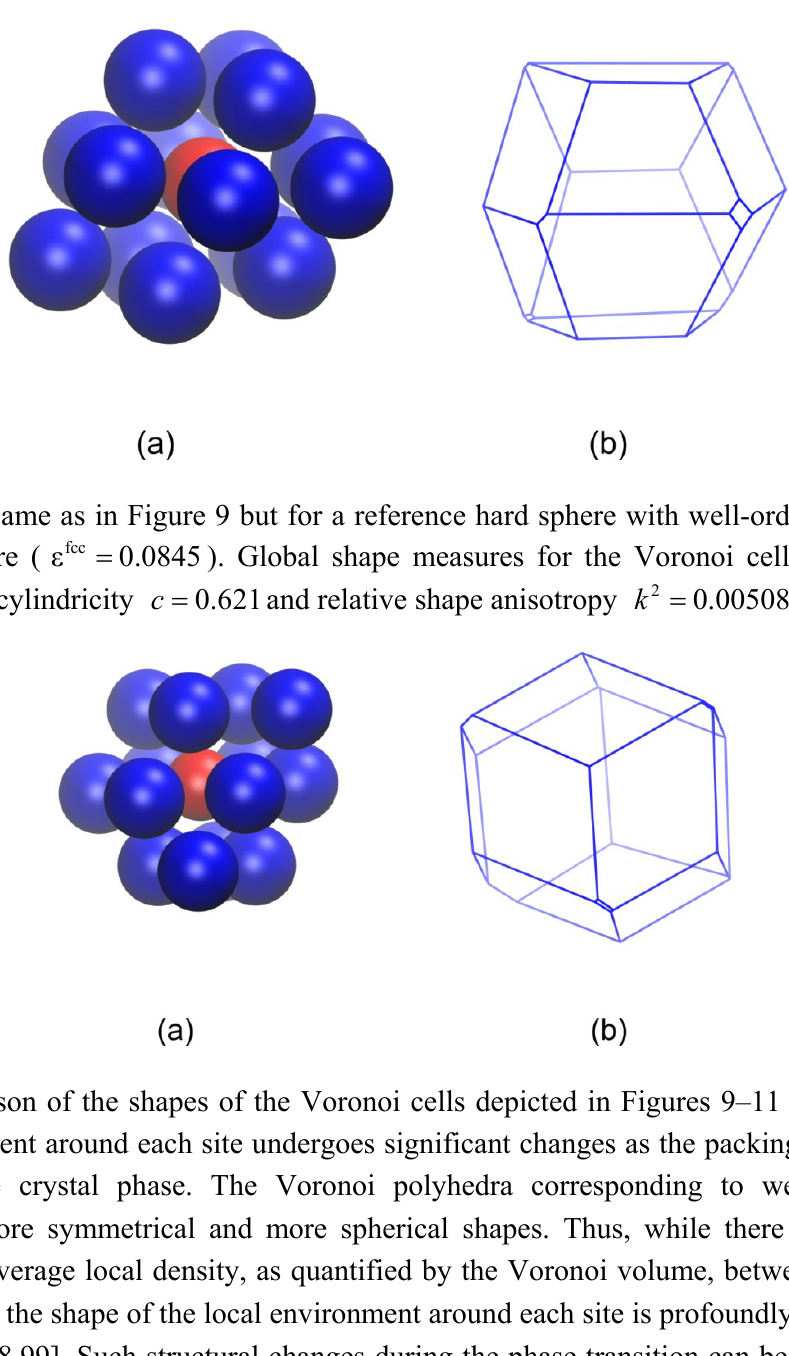
Figure 10. Same as in Figure 9 but for a reference hard sphere with well-ordered hcp-like local structure ( ). Global shape measures for the Voronoi cell: asphericity and relative shape anisotropy .